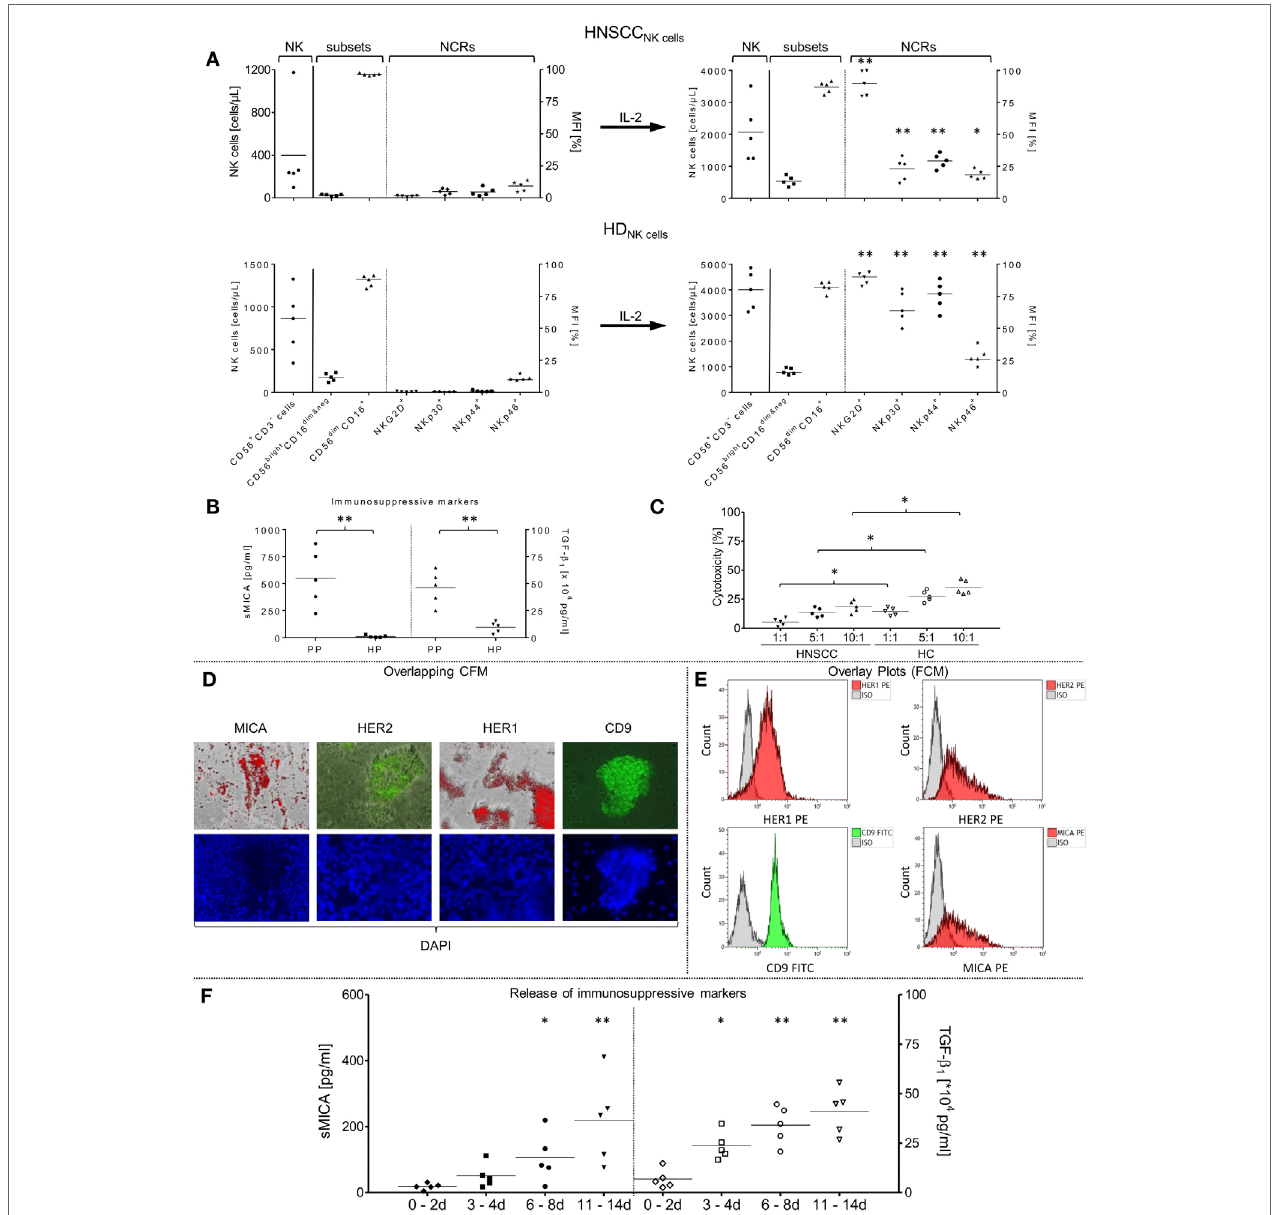
FigUre 1 | Phenotypical and functional characterizations of patient nK cell subsets and primary tumor cells from non-treated hnscc patients ( n = 5) after tumor relapse . (a) In vitro rearrangement of the NK cell phenotype was quantified in the PB before separation of NK cells and after IL-2 expansion (1000 IU/ml IL-2; 9–12 days). Shown are the absolute numbers of patient (HNSCC NK cells ) and healthy donor (HD NK cells ) CD56 + /CD3 − NK cells [cells/ μ l] [left graph area (NK)], the mean fluorescence intensity [MFI (%)] of distribution of resultant CD56 bright /CD16 dim&neg and CD56 dim /CD16 + NK subpopulations [middle graph area (subsets)] and co-expressed NCRs [MFI (%) right graph area (NCRs)] among total NK cells. (B) SMICA and TGF- β 1 levels were analyzed in blood plasma from corresponding HNSCC patients (PP) and compared to age-matched healthy donor plasma controls (HP). (c) Assessment of the basic killing activities between effector cells isolated from patient and healthy donor NK cells against SCC-4 target cells. Freshly isolated, non-stimulated NK cells from patients (HNSCC), and healthy controls (HC) were treated with corresponding HNSCC patient plasma (high sMICA/TGF- β 1 ) or associated healthy control plasma (low sMICA/TGF- β 1 ) and co-incubated for 4 h (37°C, 5% CO 2 , 250 rpm) with SCC-4 cells at the indicated E:T ratios and cytotoxicity (%) was measured by FCM. (D,e) Immunofluorescence staining and FCM-based characterization of relevant tumor antigen expression from primary tumor samples derived from corresponding HNSCC patients ( n = 5). After preparation of single cell suspensions from primary tumor samples, tumor cells were cultured (1–2 days, 37°C, 5% CO 2 ) on chamber slides and characterized phenotypically for CD9, MICA, HER1, and HER2 expression profiles by immunofluorescence microscopy. Depicted is the staining for one representative HNSCC sample. (D) The HNSCC cells were also analyzed for CD9 (FITC), MICA (PE), HER1 (PE), and HER2 (PE) surface expression levels by FCM (e) . Nuclei were stained with DAPI (4 ′ ,6-diamidino-2-phenylindole, blue fluorescence). (F) Secretion of soluble immunosuppressive factors derived from five tumor samples. SMICA and TGF- β 1 levels in expanded primary HNSCC cell cultures were analyzed by ELISAs in the collected cell medium supernatants at the indicated time frames. (a–F) Data are shown as mean ± SD from two to four experiments for the five patients. Range of statistically significant differences: from * p ≤ 0.01 to ** p ≤